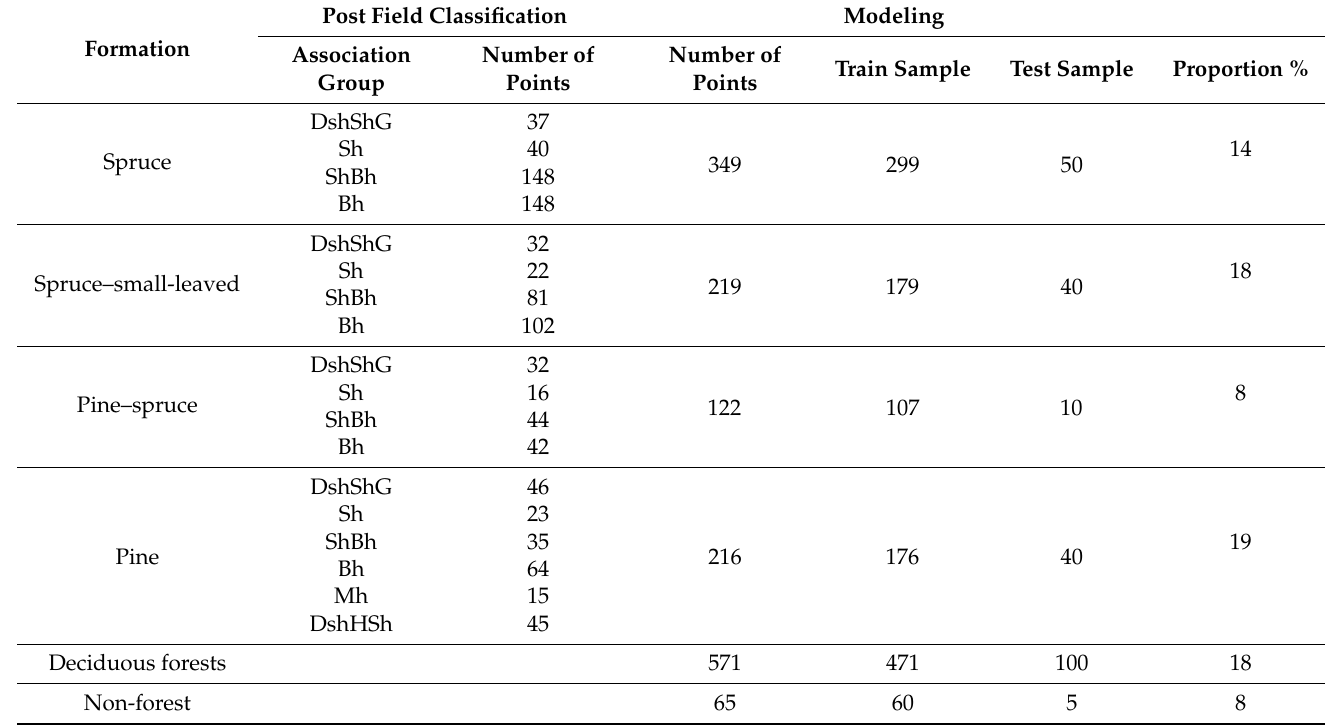
Table 1. Distribution of points of relev é s by formations and association